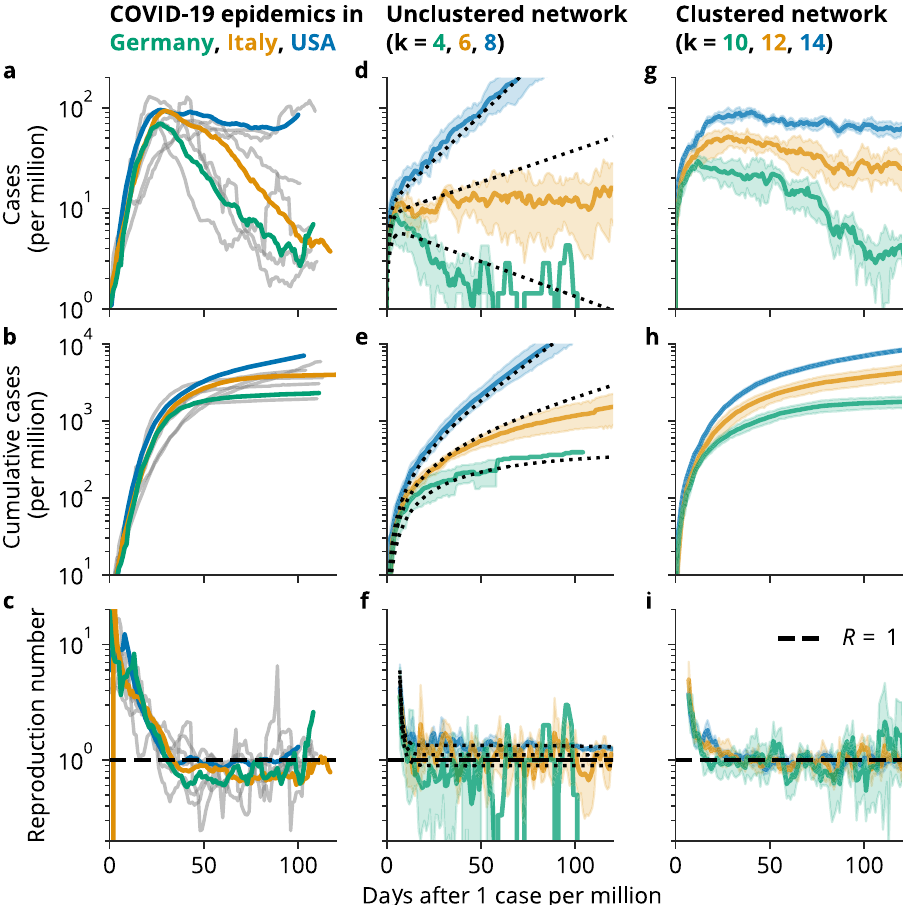
Figure 1. Dynamics of COVID-19 epidemics compared to model dynamics in hypothetical clustered and unclustered networks. ( a–c ) Seven-day rolling average of new cases per million, cumulative cases per million and reproduction number in Germany, Italy and the US, aligned to the time point when the 7-day rolling average reached one per million. After the implementation of NPIs, case numbers decrease slowly, corresponding to effective reproduction numbers of just below one. As an extreme example, in the US, case counts stayed almost constant for approximately 2 months, before increasing again. In contrast, in Germany, cases decreased by about 90% in 2 months, similar to other Western European countries (gray lines). Case counts in Italy, the epicenter of the first wave, are between those of the US and Germany. ( d–f ) Disease dynamics in a random network. The number of new cases and cumulative cases changes exponentially over time, strongly depending on the number of contacts and the infection probability. The reproduction number is equal to one only for a fine-tuned set of parameters. Black dotted lines correspond to predictions of the respective differential equation approximation. ( g–i ) Disease dynamics in a strongly clustered small-world network ( p an initial exponential increase in cases, the number of new cases is almost constant over time, corresponding to a linear increase in cumulative cases and reproduction numbers around one. This behavior is robust against changes in the total number of contacts k and the infection probability p I . ( d–i ) show mean and standard deviation of 5 independent simulations per parameter set on Watts–Strogatz networks with n data in ( a–c ) is provided by Johns Hopkins University 28